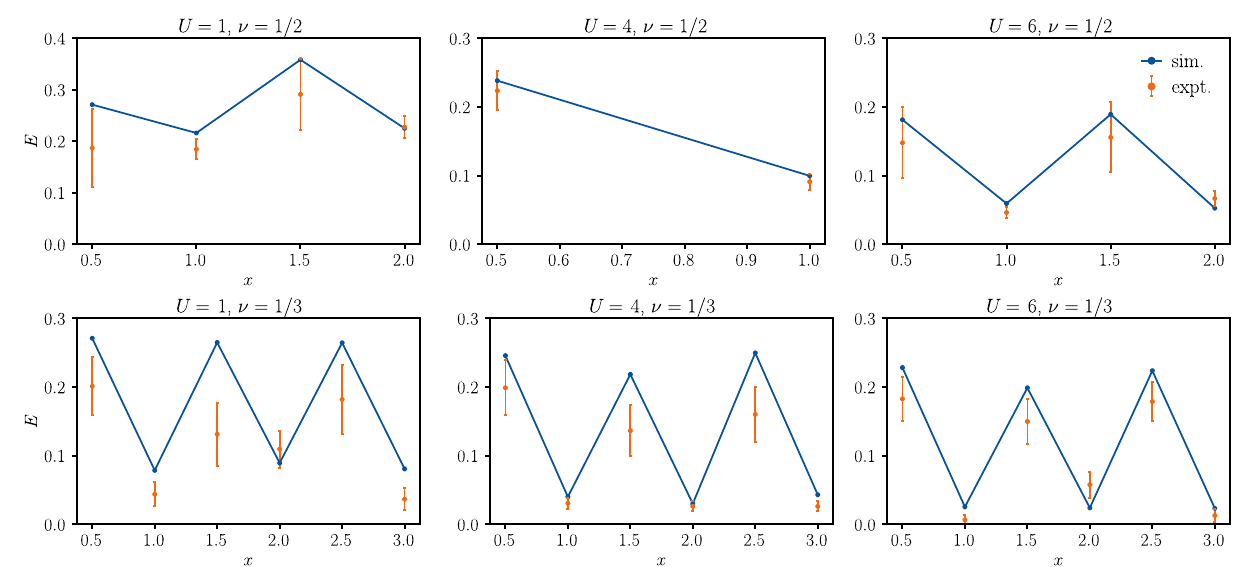
FIG. 10. Brick QMPS method measurement data of Green’s functions and density correlations of the Fermi-Hubbard model of different U s and fillings. Absolute value of hopping energies t (cid:4) 1 half-integer positions x = i − 0.5, where i labels the spinful sites. On-site repulsion density correlations (cid:4) n i ↑ n i ↓ (cid:2) are shown at site- centered coordinates (integer i ).